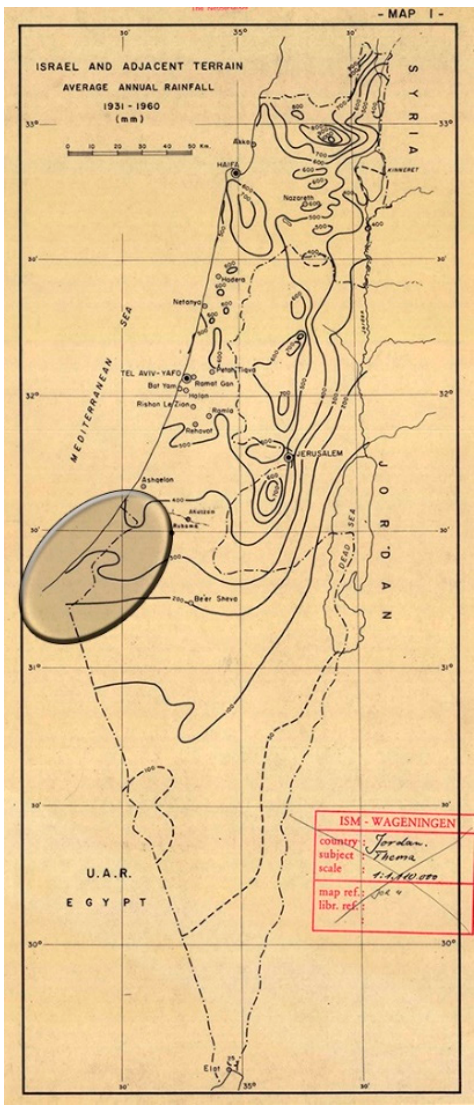
Figure 2. Average annual rainfall (1931 to 1960) [27].